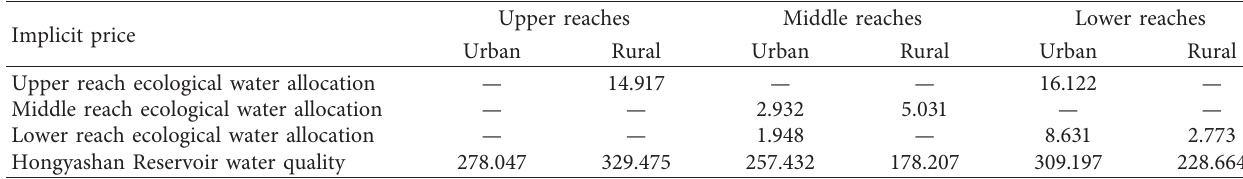
Table 5: Implicit prices for restoration indicators.